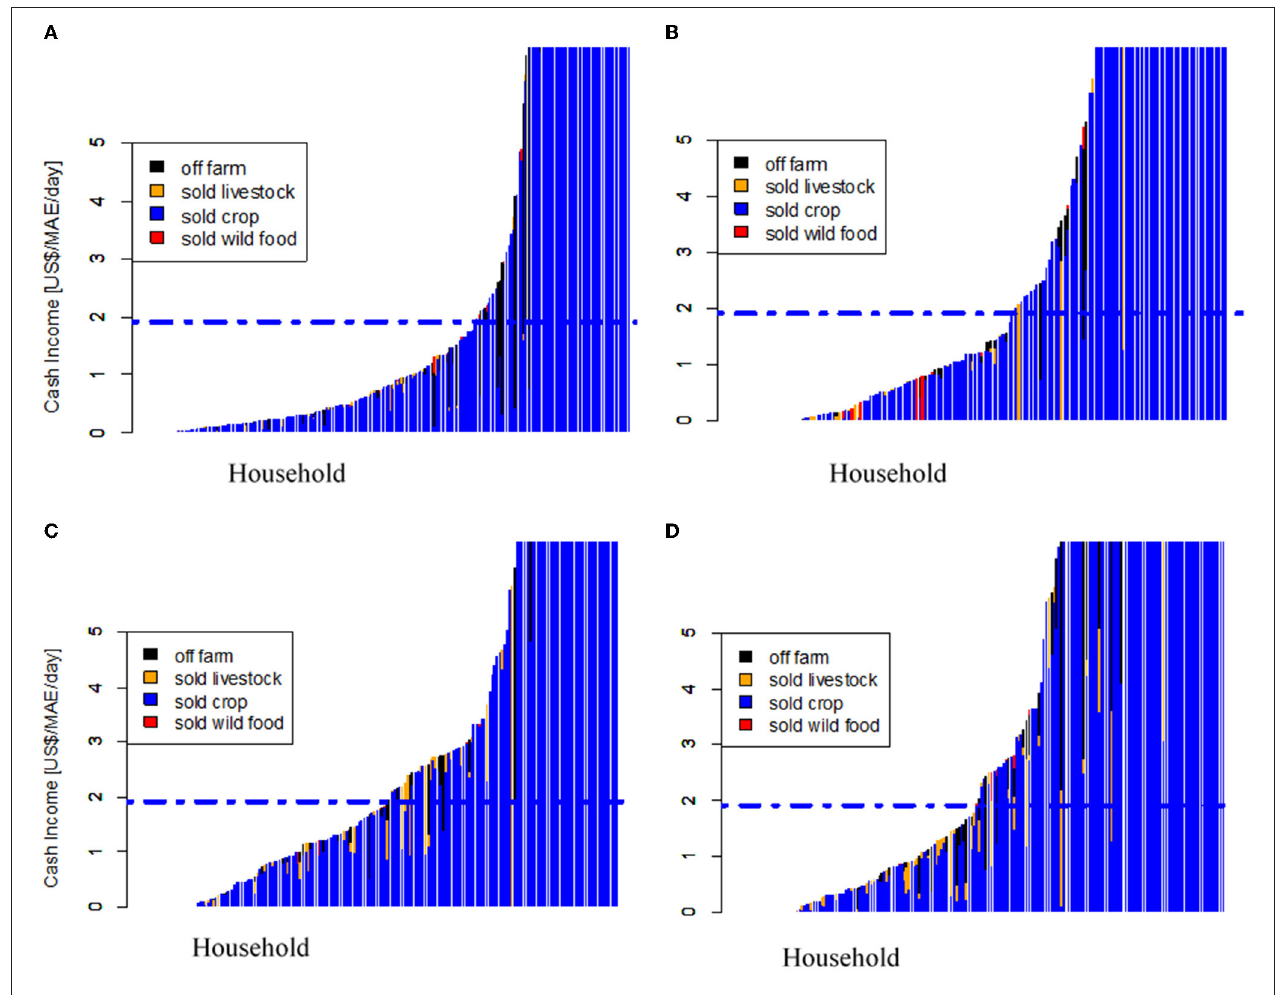
FIGURE 4 | Cash income of individual farm households (A) Bouaké [top left], (B) Gagnoa [top right], (C) Ahafo Ano North [bottom left], and (D) Ahafo Ano South [bottom right]. Individual farm households are ordered on the x-axis. The blue dotted line represents the poverty line of $1.9 day − 1 based on the World Bank international poverty line ( World Bank,